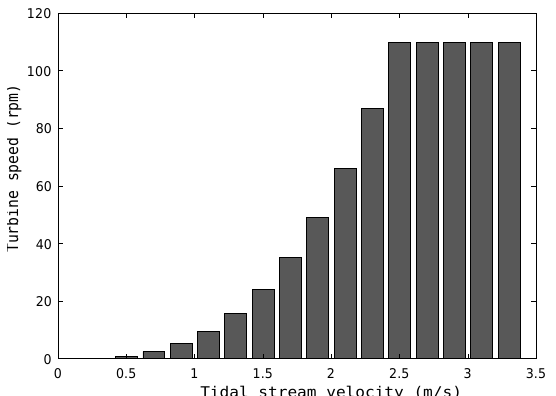
Figure 5. Power curve of the pitch- and active speed (stall)- [2] controlled tidal turbines as a function of tidal stream velocity.